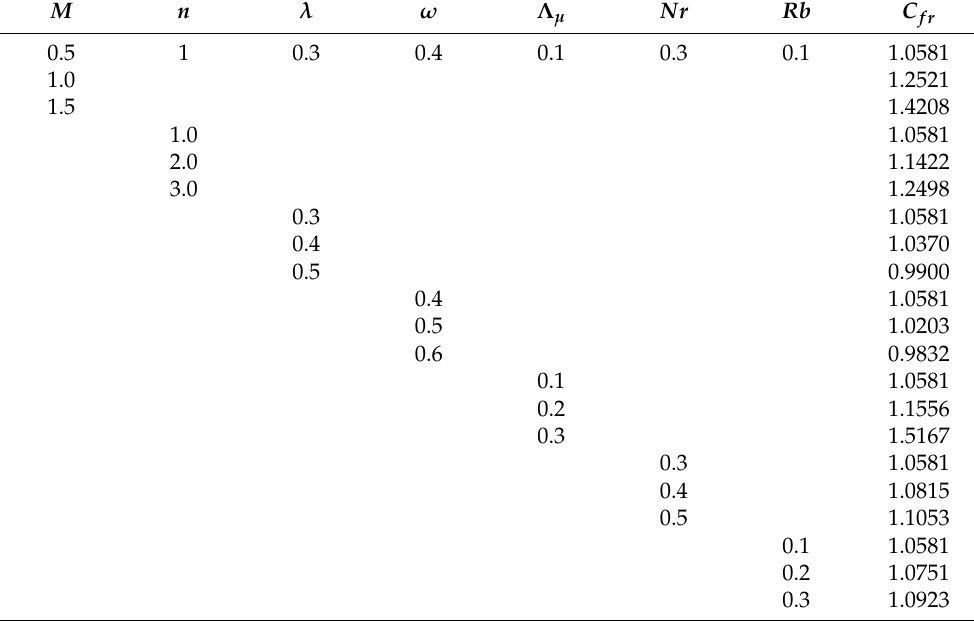
Table 3. Effect of various physical parameters over skin friction coefficient Re λ f (cid:48)(cid:48) ( 0 ) 2 ) 2